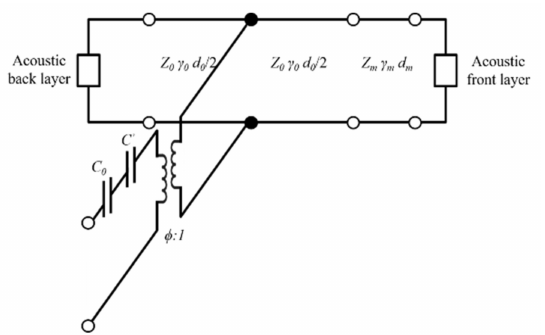
Figure 2. Krimholtz, Leedom, and Matthaei (KLM) equivalent circuit for matching